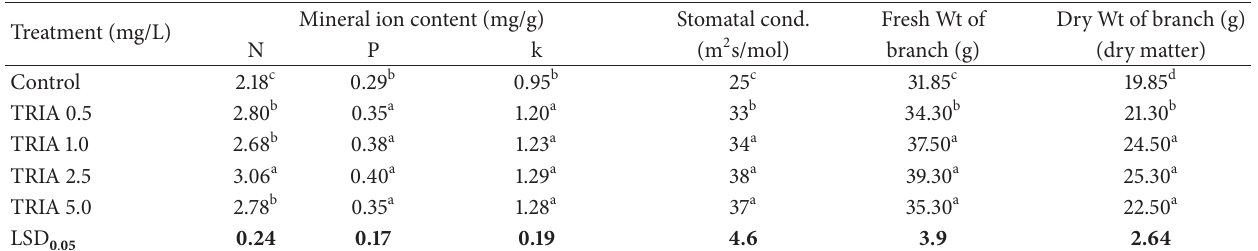
Table 2: The effects of TRIA treatments on the mineral content, stomatal conductance, and the fresh and dry biomasses of Bougainvillea glabra under natural conditions.